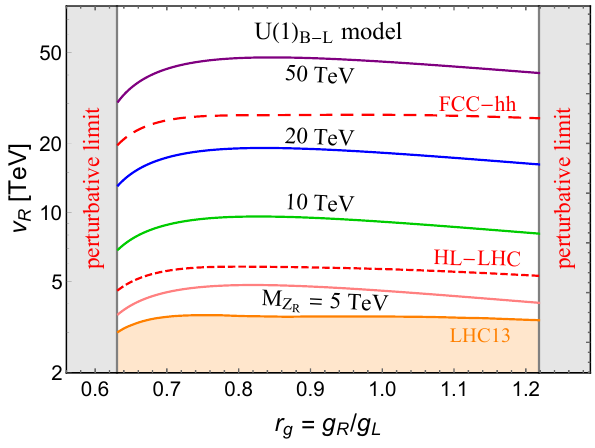
Figure 4 . Current lower bound on the v R scale in the U(1) B (cid:0) L model, as functions of r g = g R =g L , from the searches of Z R in the dilepton channel at LHC 13 TeV (shaded orange), as well as the future limit from HL-LHC 14 TeV with an integrated luminosity of 3000 fb (cid:0) 1 (short-dashed red) and the 100 TeV collider FCC-hh with a luminosity of 30 ab (cid:0) 1 (long-dashed red). The vertical shaded regions are excluded by the perturbativity constraints given in eq. (3.3). The pink, green, blue and purple contours show the variation of v R with respect to r g , with the Z R mass M Z 10, 20, 50 TeV,